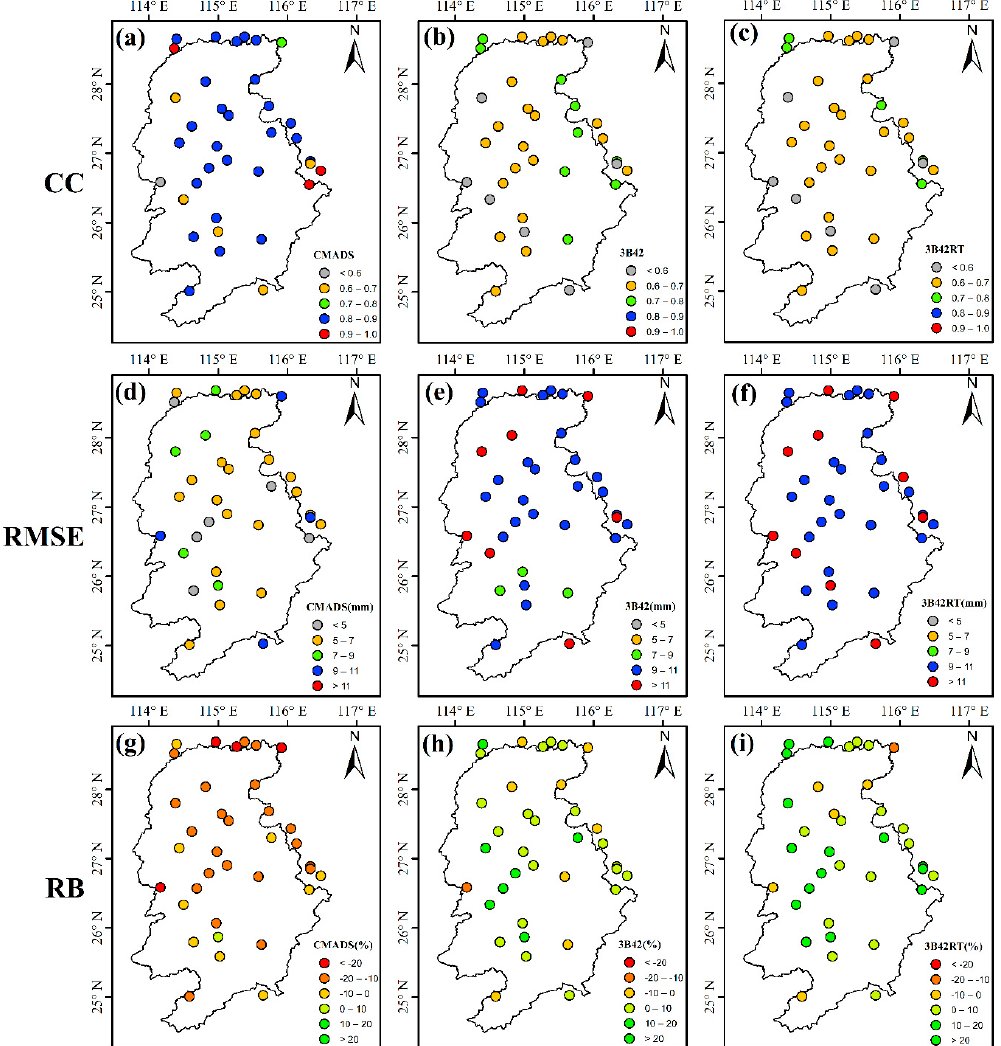
Figure 3. Spatial distribution of statistical metrics at selected pixels with rain gauges for CMADS (left column), 3B42 (middle column) and 3B42 RT (right column) in the GRB: ( a – c ) CC, ( d – f ) RMSE and ( g – i ) RB.